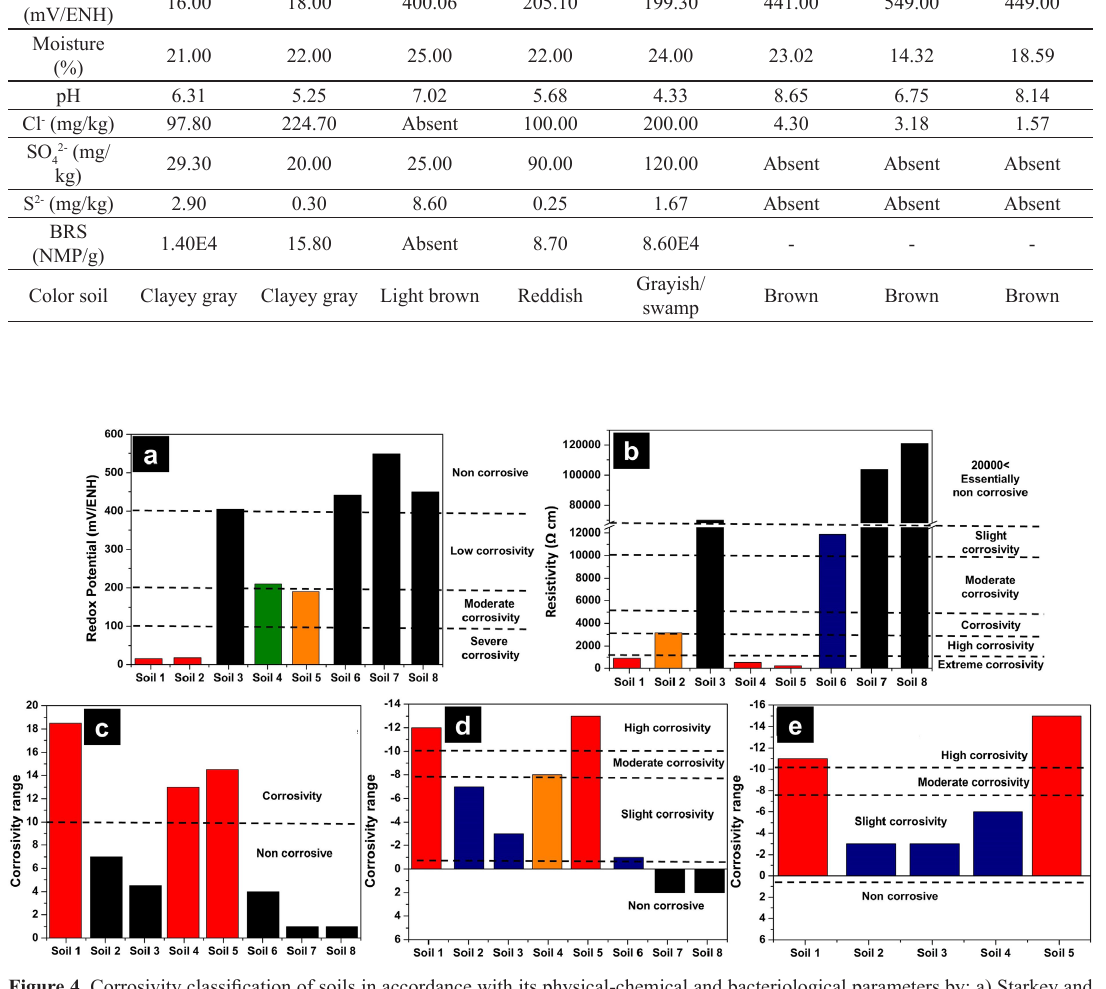
Figure 4. Corrosivity classification of soils in accordance with its physical-chemical and bacteriological parameters by: a) Starkey and Wight criteria 16 , b) Robison’s criteria 17 , c) AWWA method 18 , d) Steinrath 19 and e) Modified Steinrath Indexes 20 . The dashed lines indicate the minimal and maximum levels of aggressiveness.